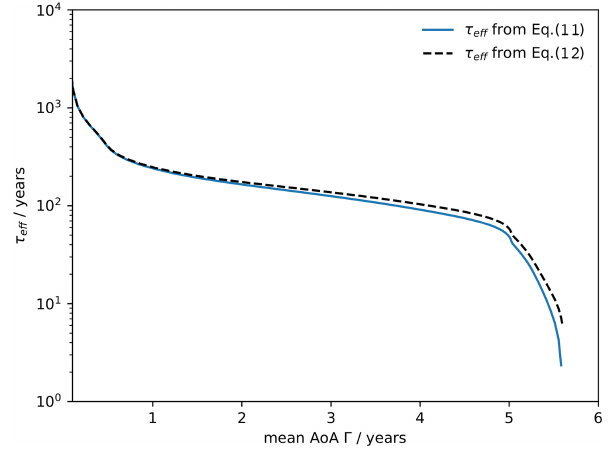
Figure 8. Effective lifetime derived from average midlatitude (30– 50 ◦ N) ideal mean AoA and apparent mean AoA (from the linearly increasing SF 6 -like tracer) from the TS2000 simulations. The cal- culation of τ eff is based on Eq. (11) (blue solid line) and its linear approximation Eq. (12) (black dashed